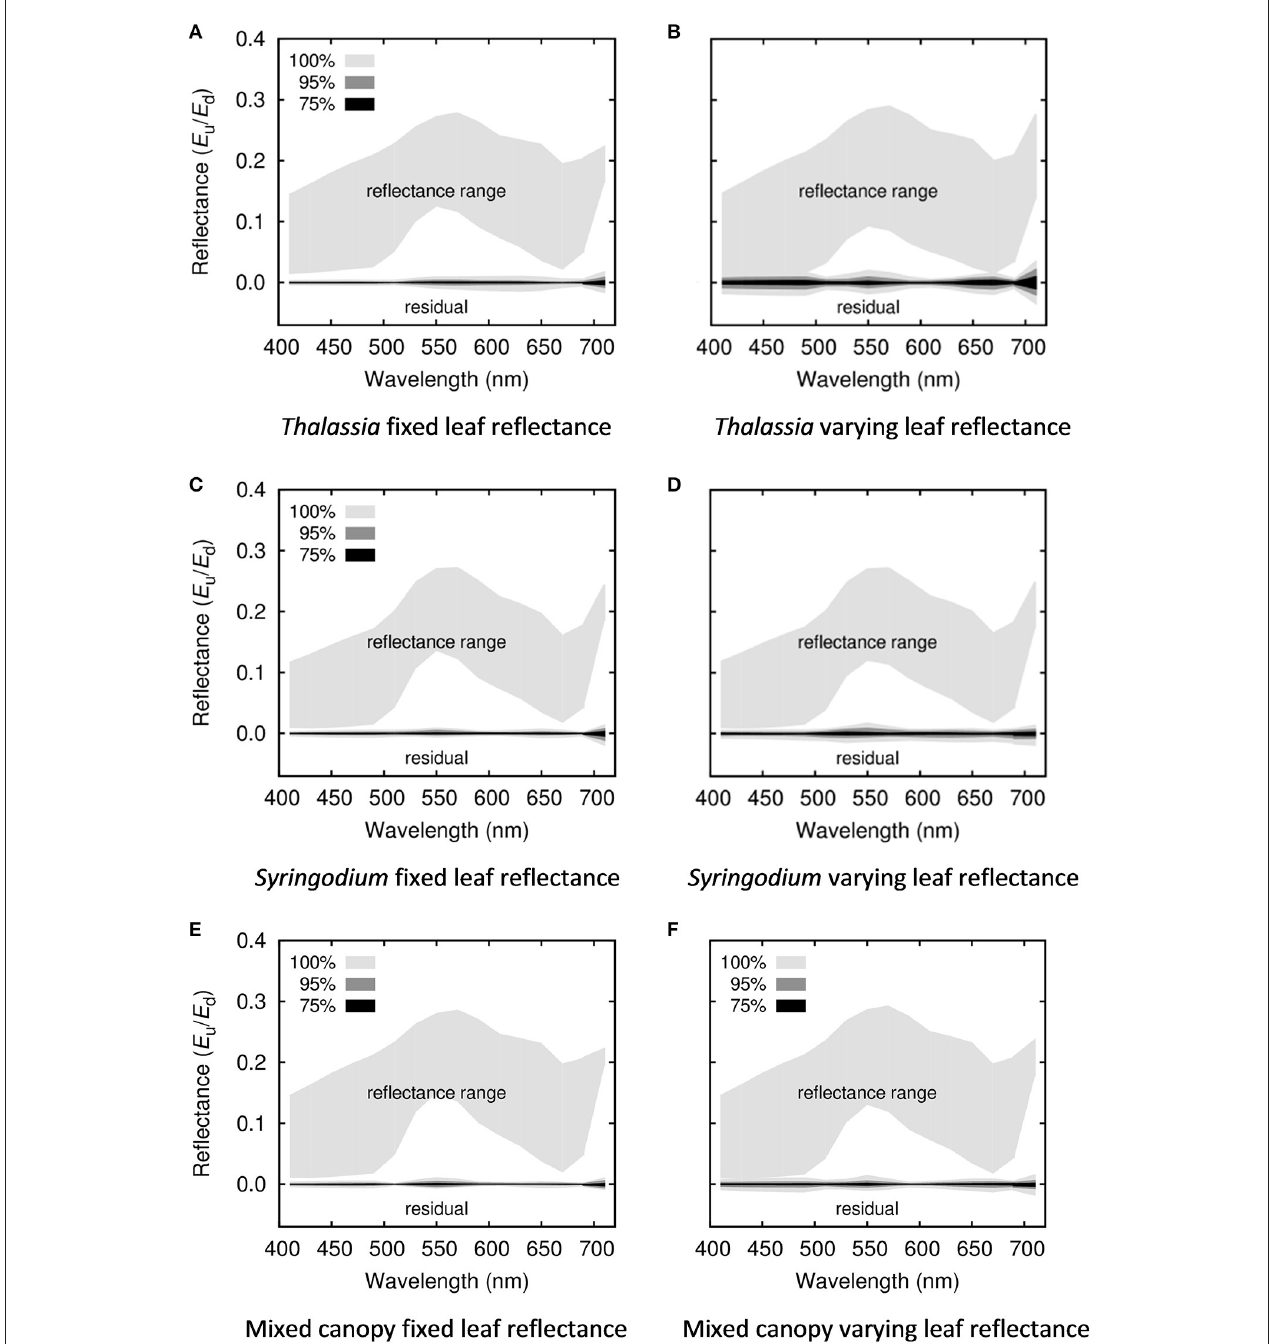
FIGURE 6 | Magnitude of discarded residuals for each of the simplified canopy models for (A,B) Thalassia , (C,D) Syringodium , (E,F) 50% mixed canopies of Thalassia and Syringodium , and for (A,C,E) canopies where leaf reflectance is fixed, (B,D,F) variable leaf reflectance. The upper region of each plot shows the full range of reflectances from all treatments in the 3D canopy model, the lower line shows the magnitude of the discarded residual error when the model is simplified, in terms of 100, 95, and 75% of the inputs, i.e., 75% of the residuals lie with the bounds of the 75% shaded region.